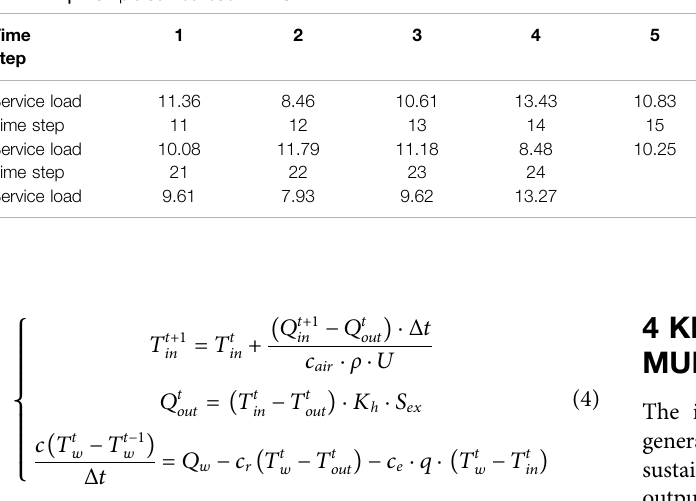
TABLE 2 | Example service load in